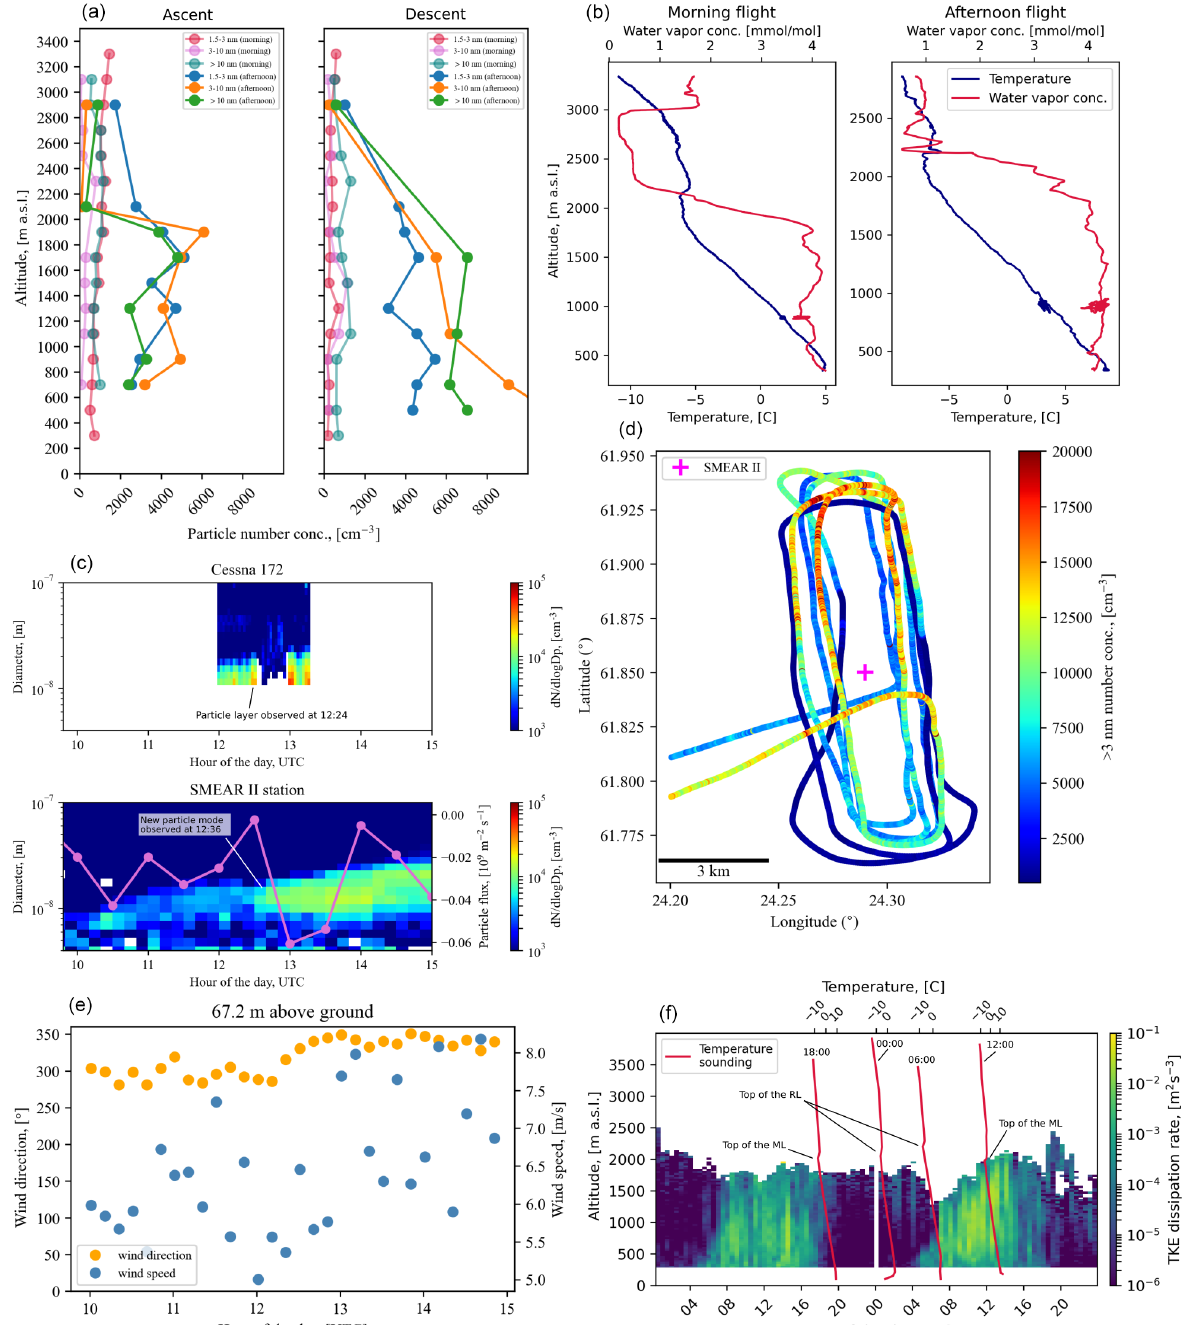
Figure 3. Panel (a) shows vertical profiles of aerosol particle number concentration in three different size ranges (1.5–3, 3–10 and > 10nm) on 2 May 2017. The data show the morning flight (02:26–03:55UTC) and the afternoon flight (12:00–13:20UTC). The profile from the afternoon flight is restricted to the northern part of the flight track (24.25–24.35 ◦ E, 61.875–61.95 ◦ N). Panel (b) shows the temperature and water vapor concentration profiles from the morning and the afternoon ascents. Panel (c) shows the particle number size distribution from the measurement airplane and the SMEAR II station. The vertical flux of > 10nm particles is superimposed. Negative means downward and pos- itive means upward particle flux. Panel (d) shows the afternoon flight track colored by > 3nm particle number concentration. Panel (e) shows the wind speed and direction from the SMEAR II mast (67.2m). Panel (f) shows the turbulent kinetic energy (TKE) dissipation rate measured by the Doppler lidar in Hyytiälä between 1–2 May 2017. Temperature soundings from Jokioinen are